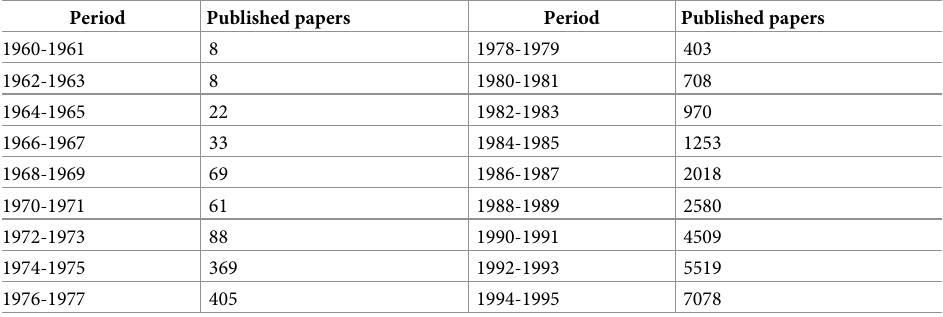
Table 4. Papers published in 2-year time